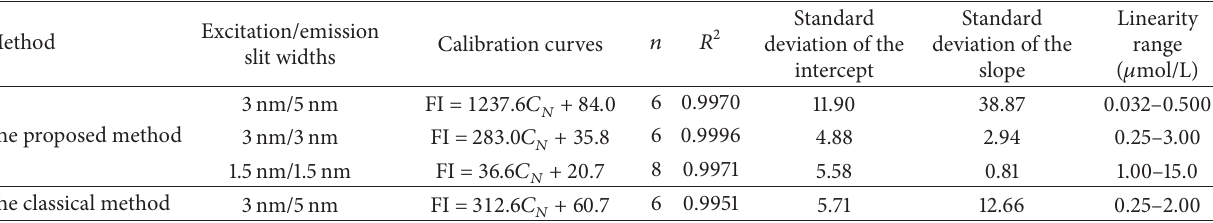
Table 3: Calibration curves and the corresponding performances.